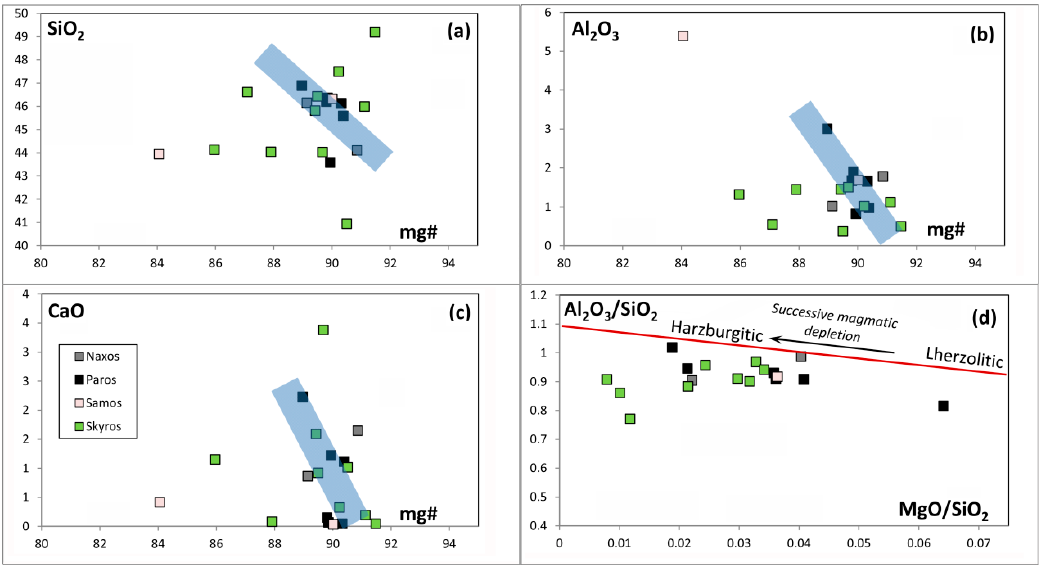
Figure 9. Variation diagrams of ( a ) SiO 2 ; ( b ) Al 2 O 3 and ( c ) CaO vs. Mg# as fractionation index for the Aegean ultramafic rocks; ( d ) Binary diagram of Mg/SiO 2 vs. Al 2 O 3 /SiO 2 with serpentinized peridotites and serpentinites. Successive magmatic depletion line according to [69–71]. The shaded field shows the main magmatic trend defined by Paros samples. Skyros serpentinites display the largest scatter, due to alteration effects.